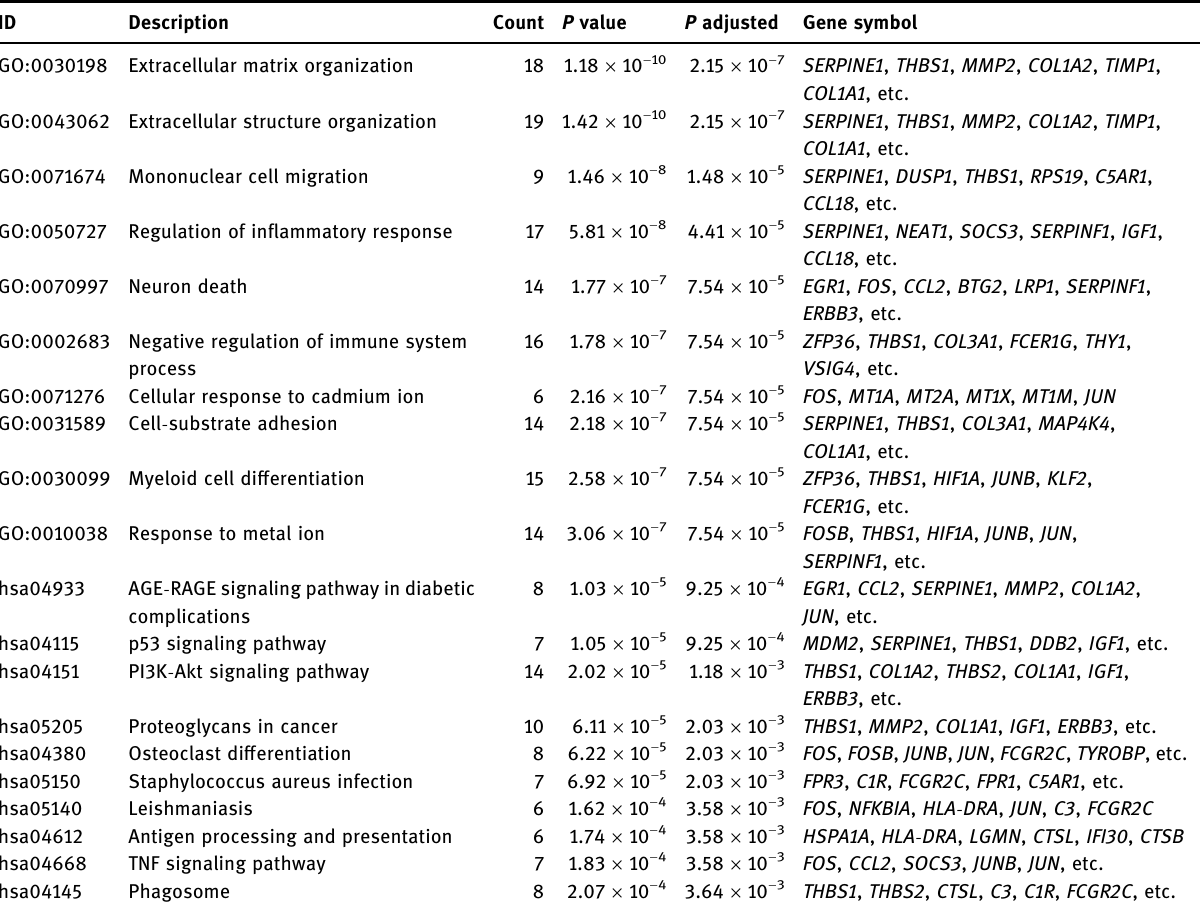
Table A2: The top 15 gene ontology biological processes and the KEGG pathways related to the upregulated radiation - associated genes in breast cancer ( BCa